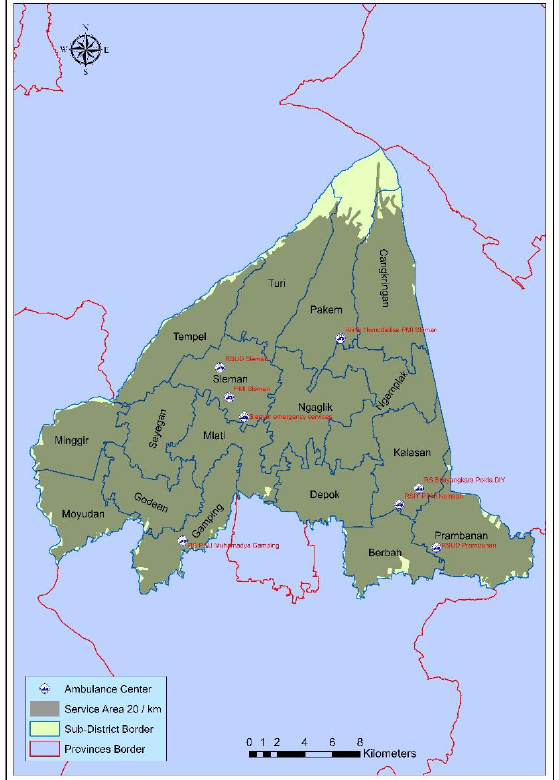
Figure 2. The service area of Ambulance centers in the study area based on the distance standard (20